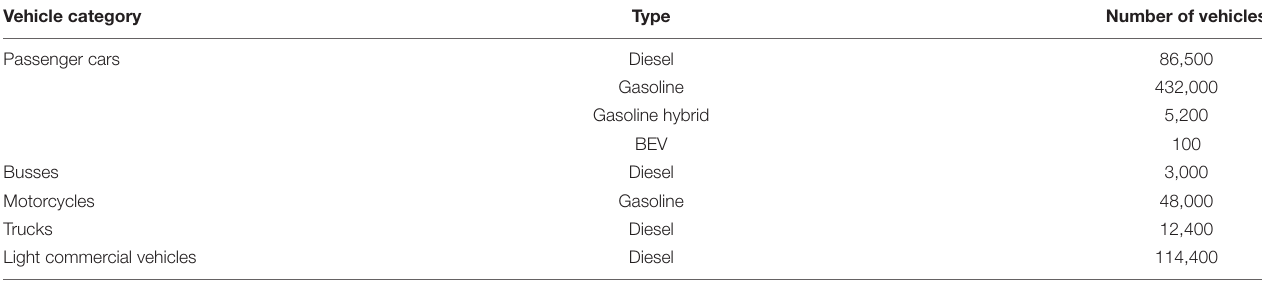
TABLE A1 | Existing vehicle fleet in 2017.